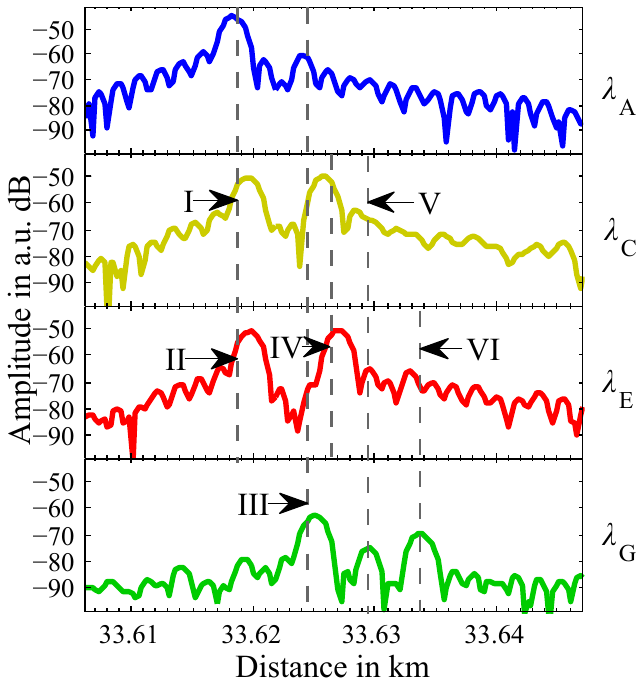
Figure 6. Results of Linear-Frequency-Chirp OTDR